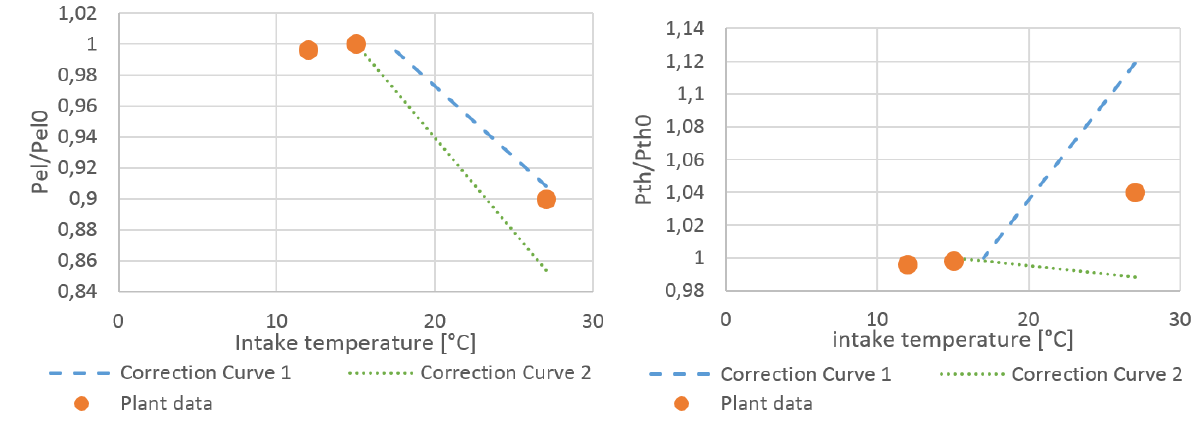
Figure 5. (a) Operating points for electric power production and (b) for thermal power production as a function of ambient temperature.